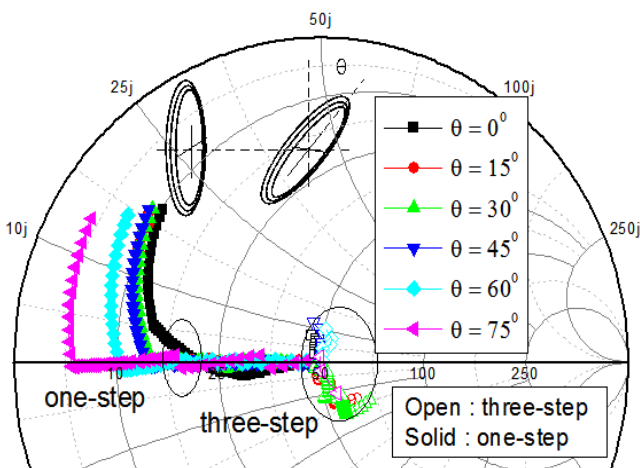
Figure 17. Trajectory of the measured input impedance for different angular misalignments from θ = 0° to 75° in 15° steps, d = 40